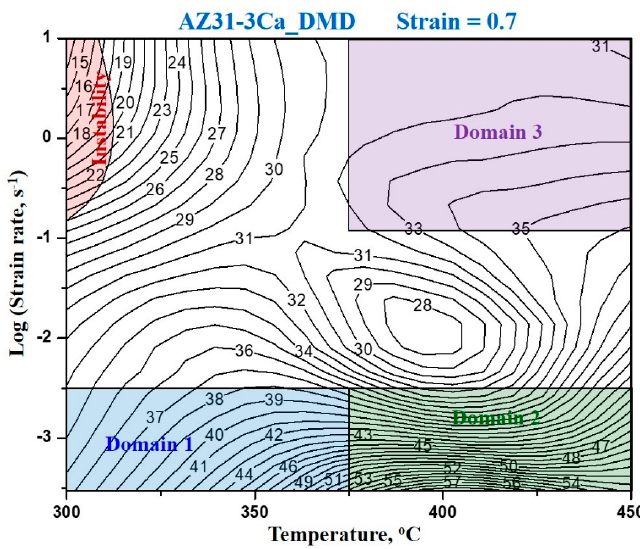
Figure 6. Processing map for DMD processed AZ31-3Ca alloy at a strain of 0.7. The numbers on the contours represent efficiency of power dissipation in percent.